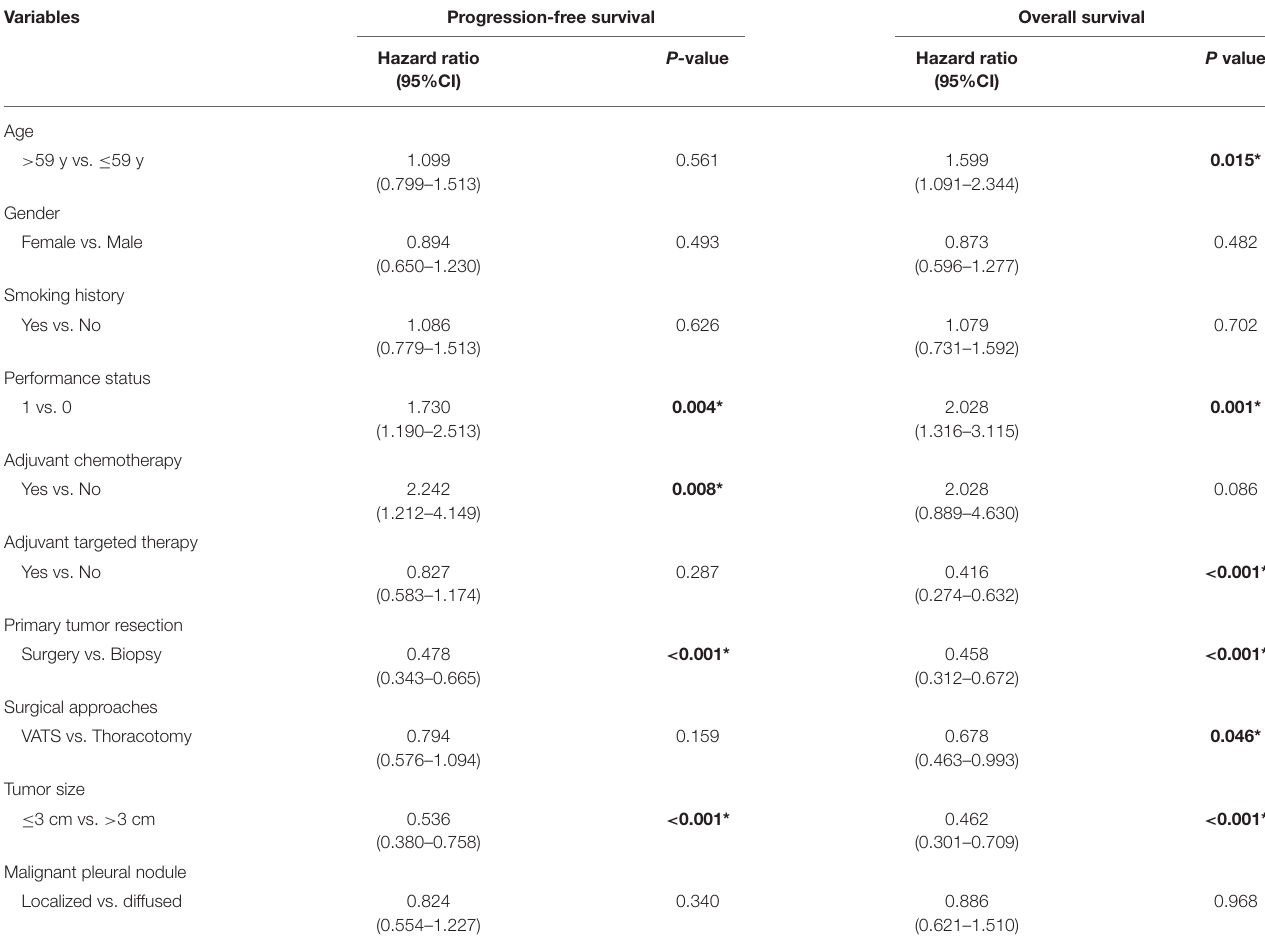
TABLE 3 | Univariate analysis of prognostic